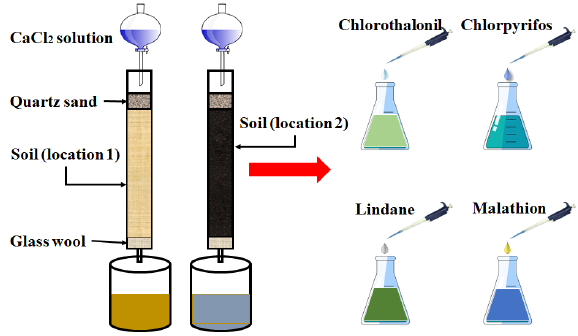
Figure 1. The diagram for preparation of groundwater samples containing